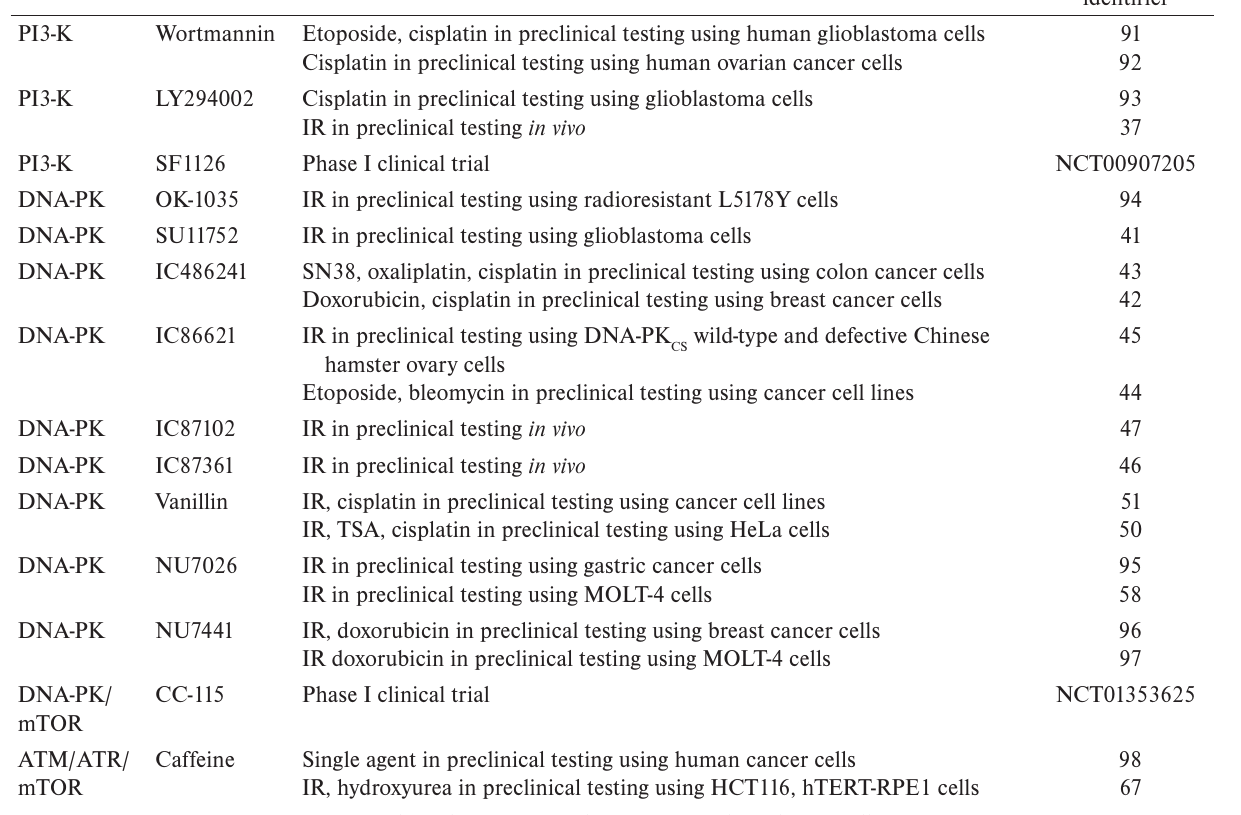
Table 1. Small molecule inhibitors of DNA repair kinases in preclinical or clinical development for cancer therapy. Inhibitor Specifity